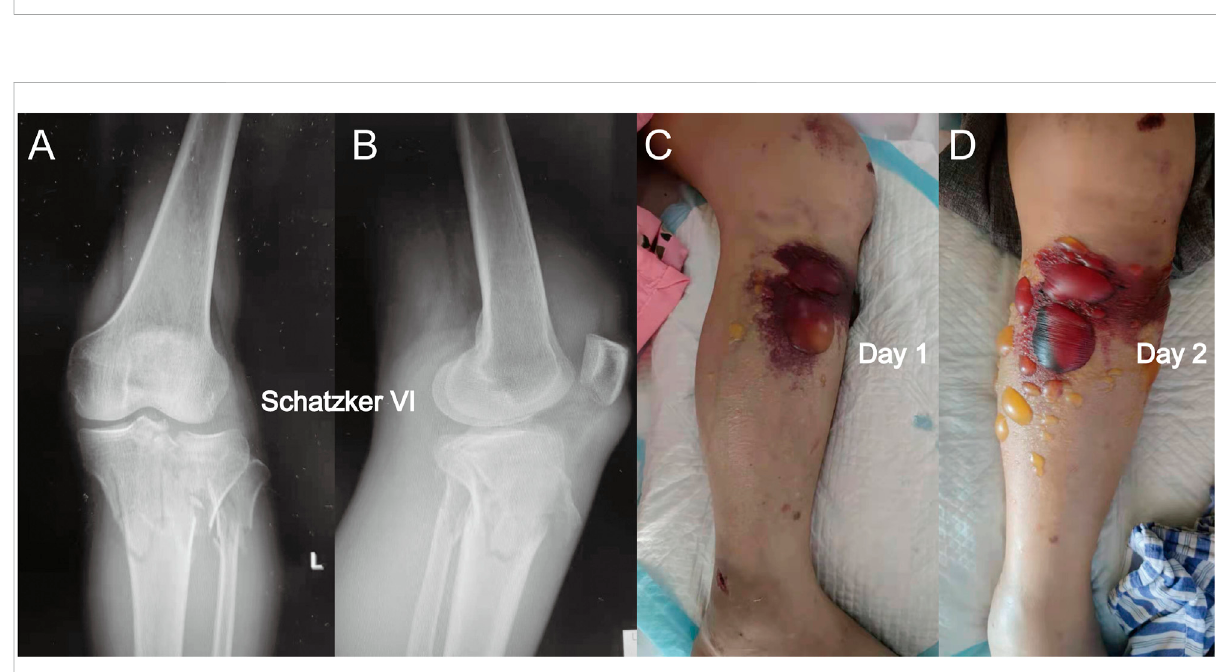
FIGURE 1 (A) Anterior-posteriorX-raysofaSchatzkerVItibialplateaufracture. (B) Lateralviewofthisfracture. (C) Fractureappearancewithaserous- fi lled blister observed on the skin around the fracture site (proximal tibia) after admission. (D) Blister became larger after 1 day, and the patients were not subjected to fasciotomy. When a blister was observed, the intracompartmental pressure decreased signi fi cantly.